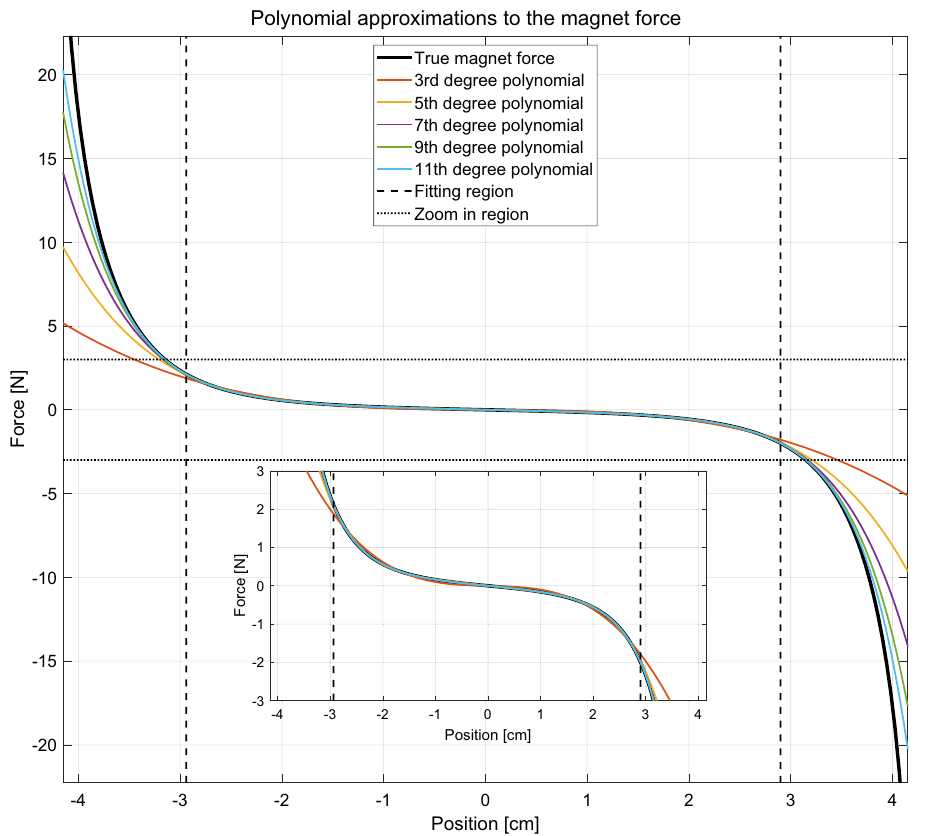
Figure 8. Polynomial fits of increasing order of the true force, F m